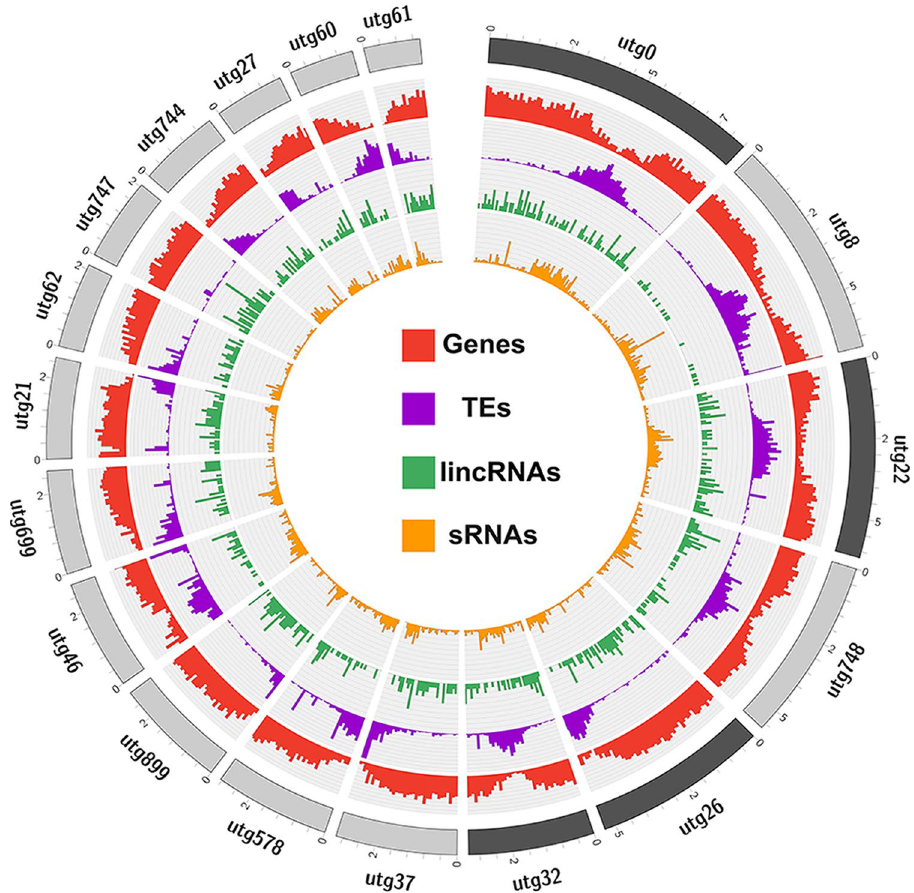
Figure 2. Noncoding RNA landscape in Utricularia gibba. Representation of the U. gibba genome in a circus plot where the outside blocks represent complete chromosomes (dark gray) and Unitigs or contigs (gray) larger than 1 Mb in size. The density plots were calculated in 10Kb windows. Red histogram shows the gene density. The Purple histogram displays transposable element density. lincRNA density is represented in the green histogram, and small RNA density for sRNAs 20-nt to 24-nt in size are shown in